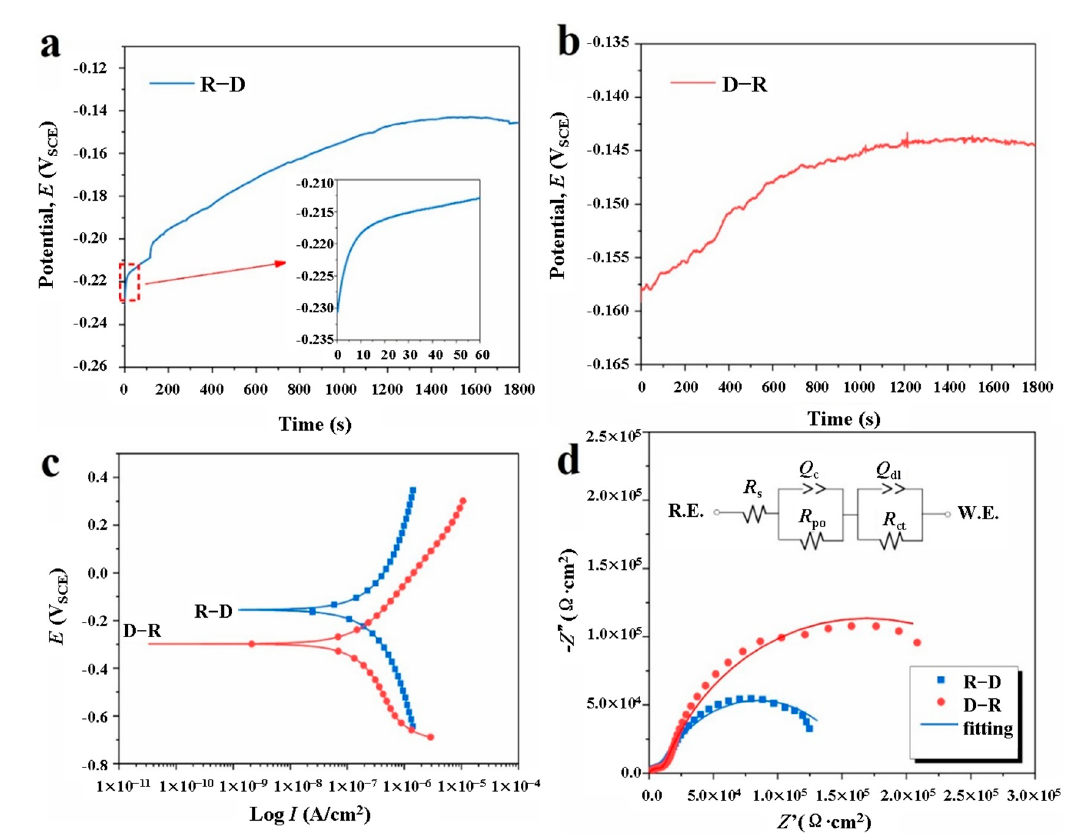
Figure 5. Variation of corrosion potential versus time (0–1800 s) for ( a ) R-D and ( b ) D-R samples. ( c ) potentiodynamic polarization curves and ( d ) Nyquist plots of EIS spectra of the different coatings. The inset is the equivalent electrical circuit